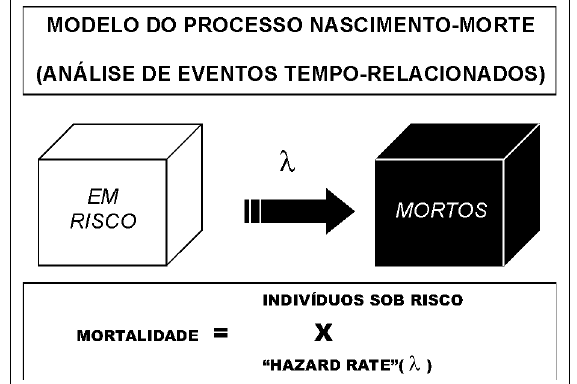
Fig. 1 - Esquema da análise de eventos tempo-relacionados. (Fonte: Kirklin J W & Barrat-Boyes B G. Cardiac surgery. 2.ed. New York: Churchill Livingstone, 1993.